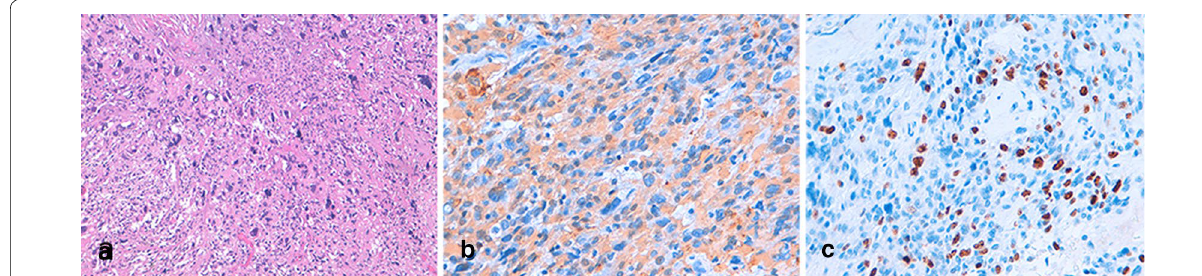
Fig. 3 Histopatologic features of the spinal GBM of the conus medullaris. Microscopy demonstrates a neoplastic proliferation of polymorphous glial cells characterized by anisocaryosis and atypical mitosis. a Focal necrosis, calcifications, and areas with multinucleated cells are present ( 40). × b Immunohistochemistry shows positivity for glial fibrillary acidic protein (GFAP) and S100 and negativity for sinaptofisine, neurofilaments, and the epithelial membrane antigen (EMA) ( 63). c The proliferation index (anti‑Ki67) is 15% ( × ×